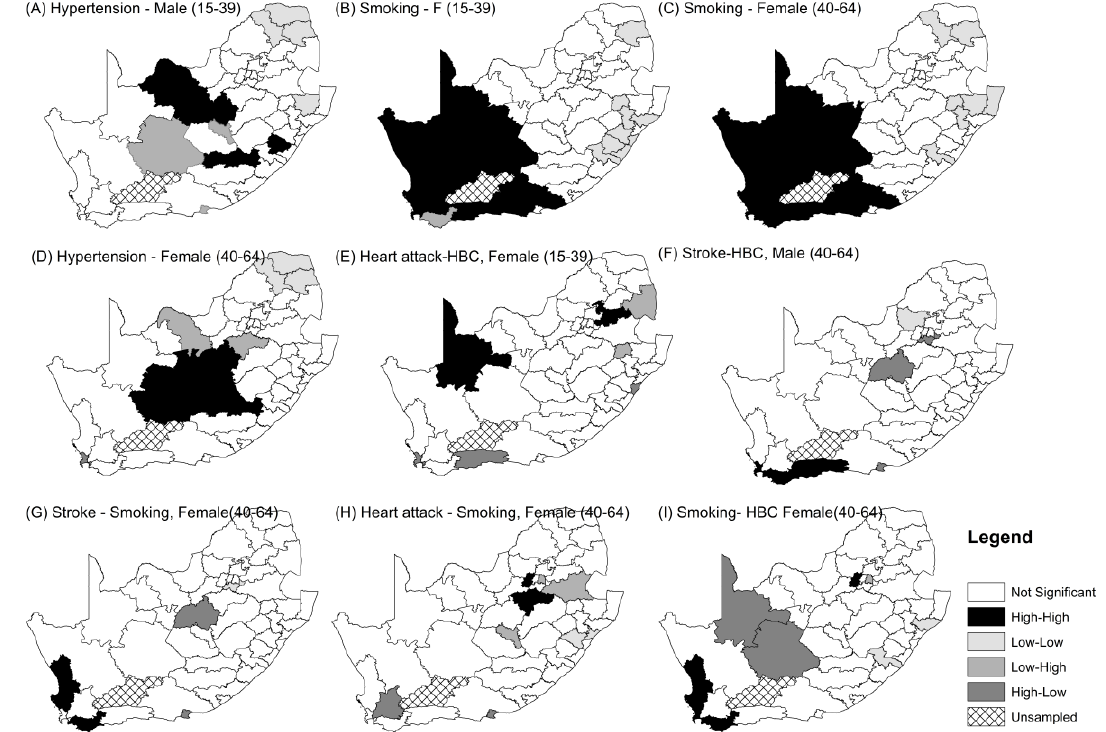
Figure A2. Univariate LISA cluster for the standardized incidence ratios of stroke, heart attack, hypertension, high blood cholesterol and Smoking.